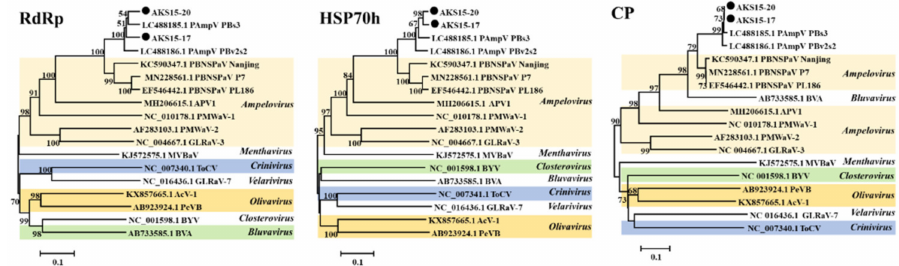
Figure 3. Phylogenetic analysis of PAmpV-Ju variants AKS15-17 and AKS15-20, PAmpV and repre- sentative members of the family Closteroviridae based on the amino acid sequences of their RdRp, HSP70h, and CP. The phylogenetic trees were constructed using a neighbor-joining algorithm with 1000 bootstrap replications; bootstrap support values >50% are shown at the nodes. PAmpV, per- simmon ampelovirus; PBNSPaV, plum bark necrosis stem pitting-associated virus; APV1, air potato virus 1; PMWaV-1, pineapple mealybug wilt-associated virus 1; PMWaV-2, pineapple mealybug wilt-associated virus 2; GLRaV-3, grapevine leafroll-associated virus 3; MVBaV, mint vein banding- associated virus; ToCV, tomato chlorosis virus; GLRaV-7, grapevine leafroll-associated virus 7; AcV-1, actinidia virus 1; PeVB, persimmon virus B; BYV, beet yellows virus; BVA, blueberry virus